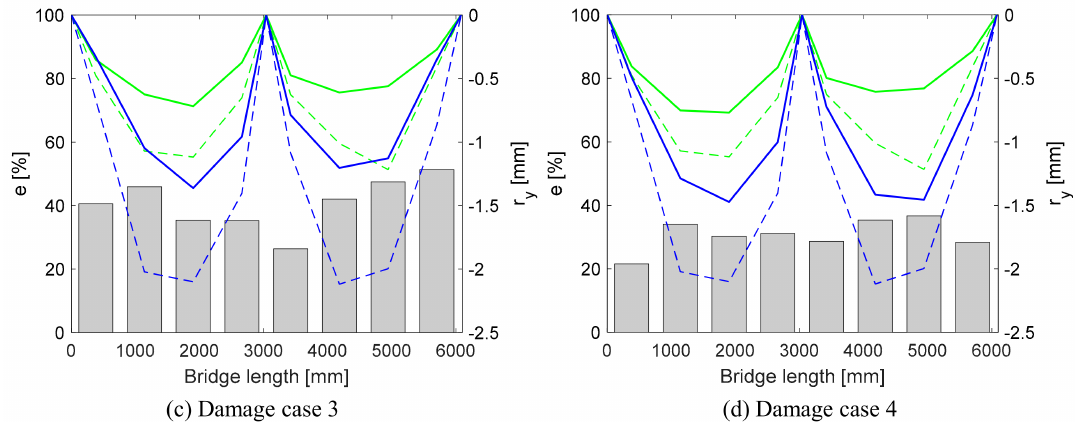
Figure 8. Damage feature ( e ) (bars) and vertical displacement range ( r v ) expressed as a negative value. The thick green (Girder A) and blue (Girder B) lines are the r v values at the damage cases, with dashed lines at the